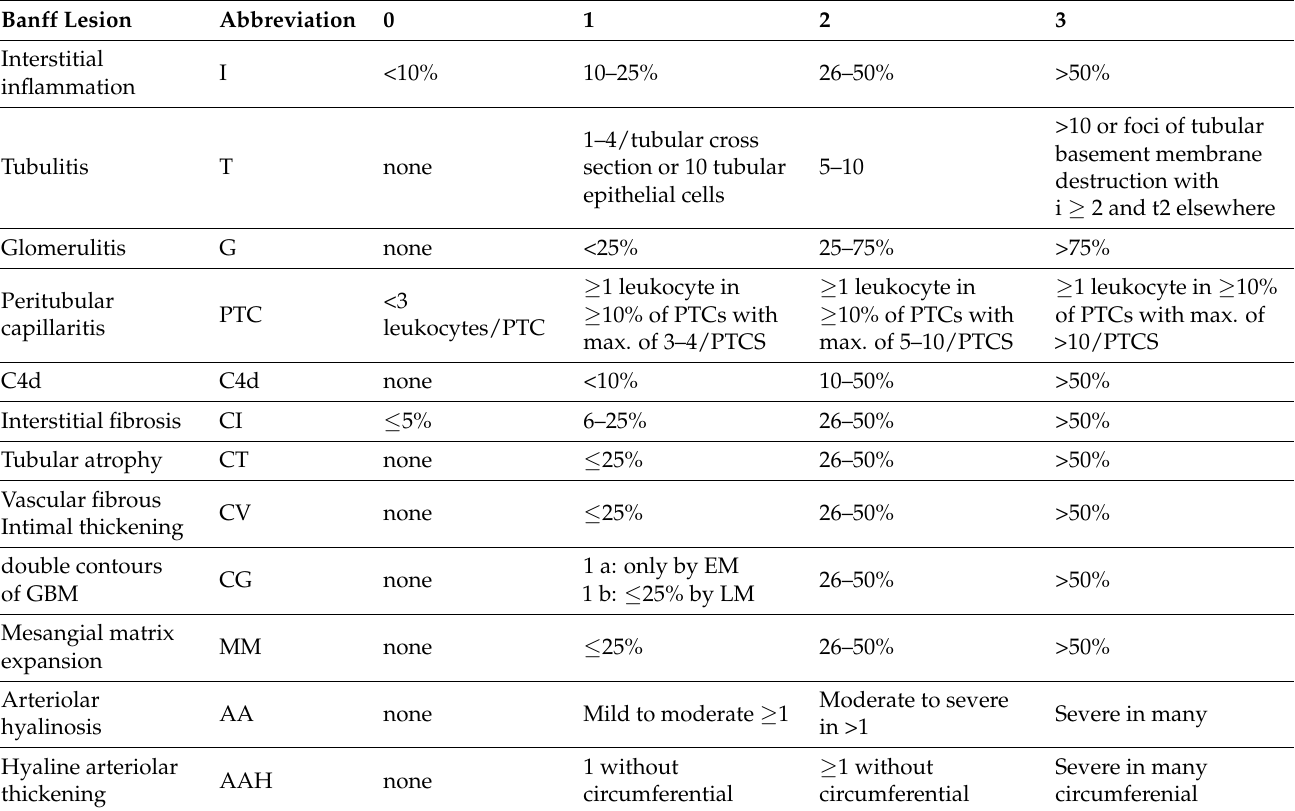
Table 1. The thresholds for evaluated Banff Lesions Score according to Banff Classification